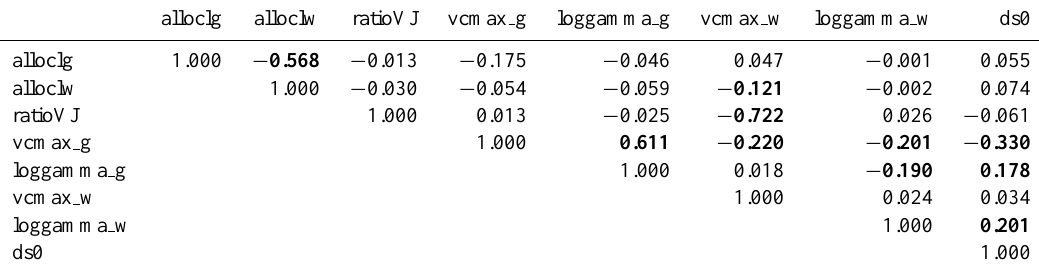
Table D1. CABLE-SLI.